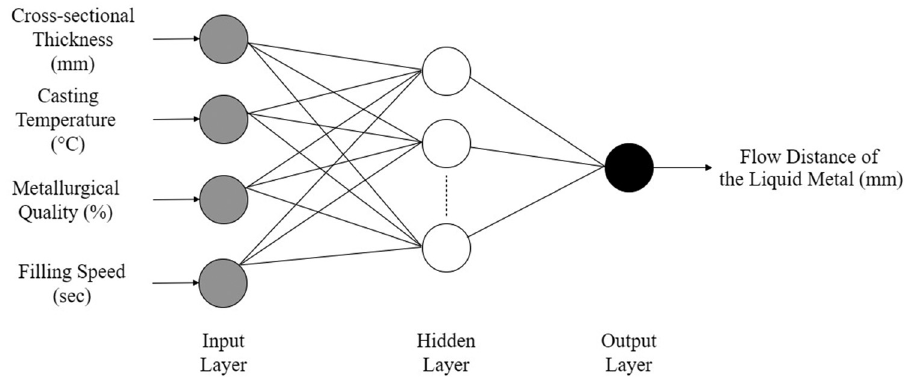
Figure 3: The topology of the developed ANN model.